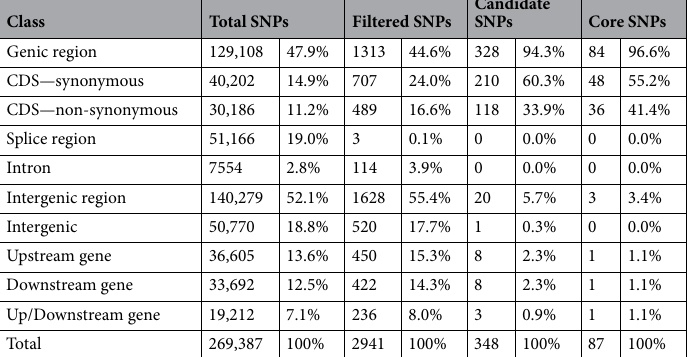
Table 3. Chromosomal location of SNPs identified in 96 cabbage varieties. SNP, single nucleotide polymorphism; CDS, coding